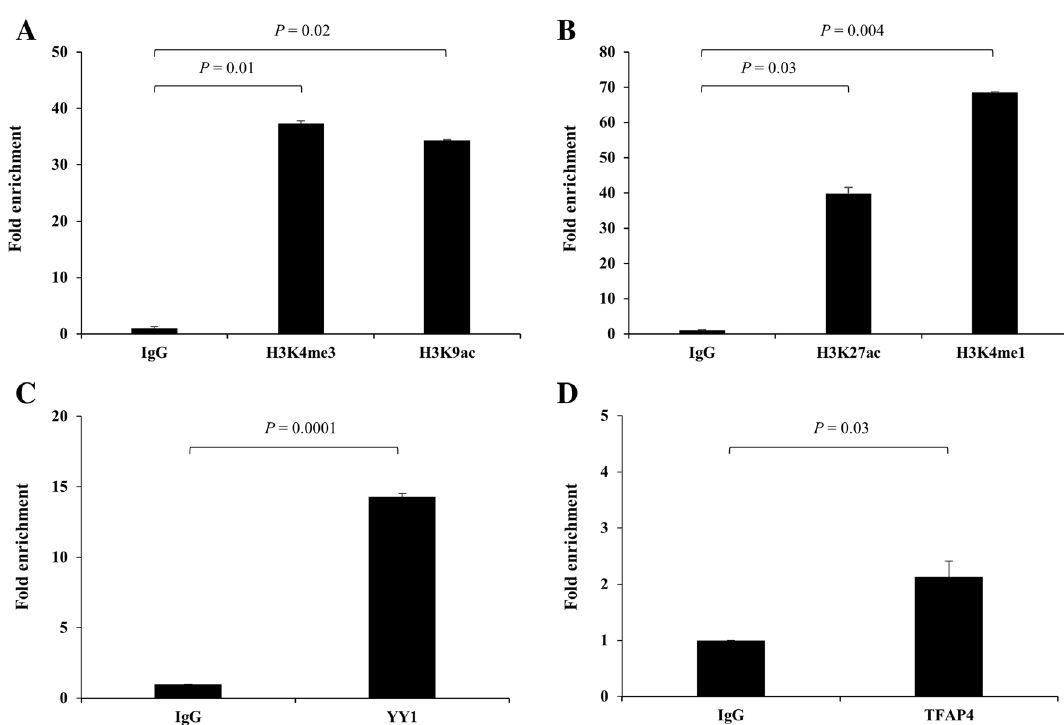
Figure 4. ChIP-qPCR analysis of H3K4me3 and H3K9ac ( A ) and YY1 ( C ) binding at CAPN1 rs17583, and H3K27ac and H3K4me1 ( B ) and TFAP4 ( D ) binding at LINC00959 rs4751162. The data were analyzed using Excel. Each bar represents mean ± SEM from three independent experiments carried out in triplicate. P values by Student’s